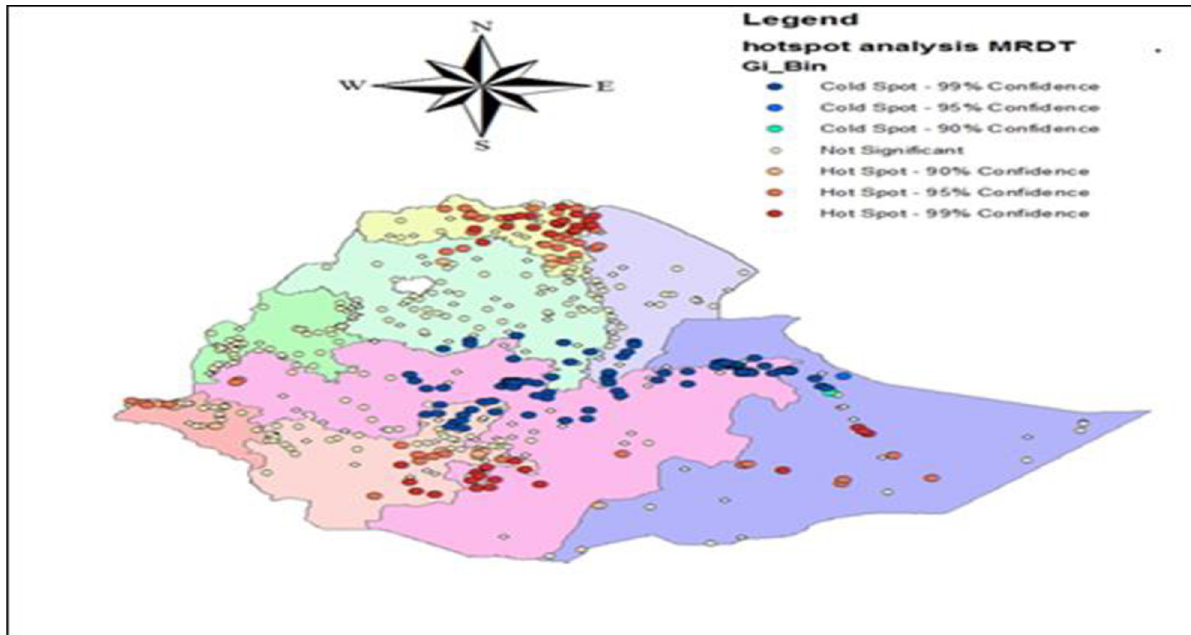
Fig 2. Hotspot analysis of malaria diagnosis test, from EMIS